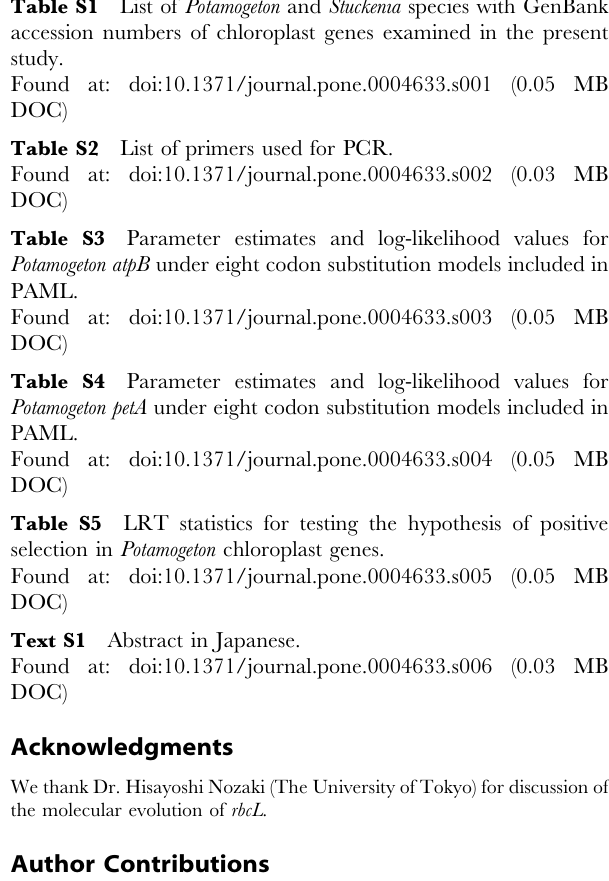
Table S1 List of Potamogeton and Stuckenia species with GenBank accession numbers of chloroplast genes examined in the present study.